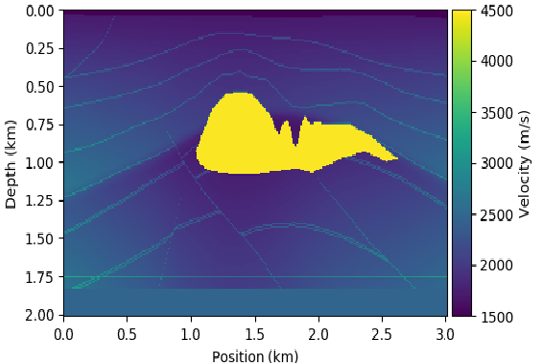
Figure 1. Sample velocity model of the 2D SEG Salt data.